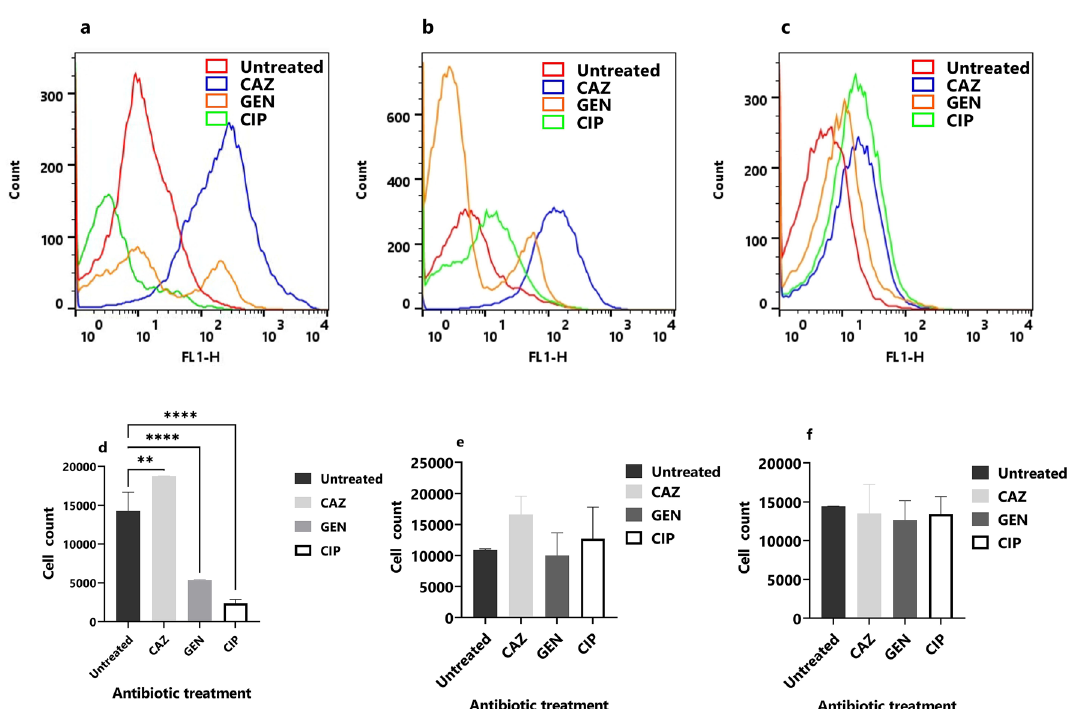
Figure 6. Cellular redox activity in the biofilm stage. The flow cytometry of ( a ) PAO1 ( b ) TP-10 and ( c ) ST-13 biofilms was done using RSG and PI staining after 4 h of antibiotics treatment (CAZ, GEN, and CIP). Untreated was used as a control. ( d–f ) The quantitative data of RSG-positive cells (in PAO1, TP-10 and ST-13) using flow cytometry analysis after treatment with respective antibiotics were compared to the untreated control. CAZ: ceftazidime, GEN: gentamicin, and CIP: ciprofloxacin. The corresponding data represent the mean ± standard deviation. The experiment was performed in three biological triplicates for each strain. Statistical analysis was performed using a one-way ANOVA, which were * P < 0.05, and ** P < 0.01, *** P < 0.001, and **** P <